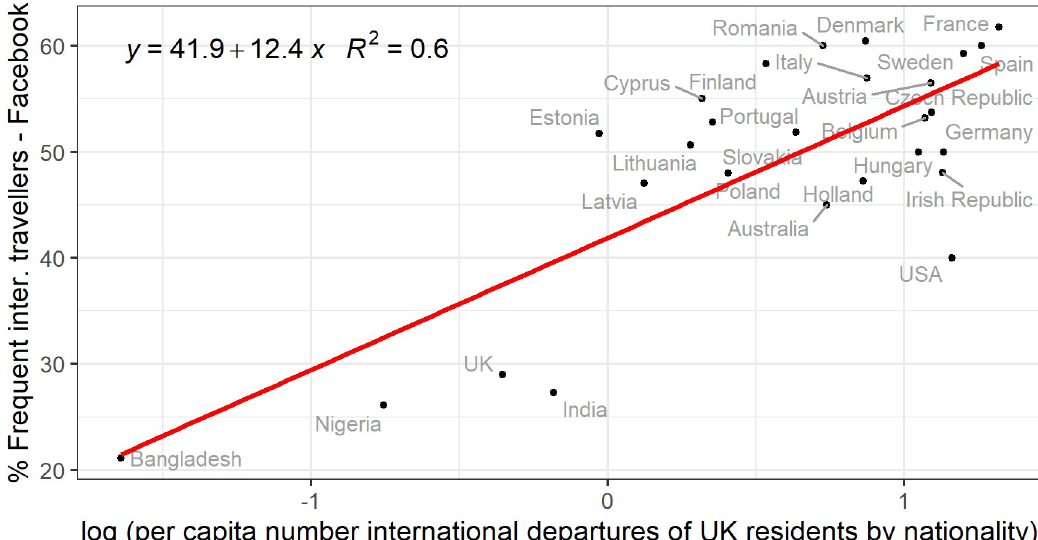
Fig 1. International travelling behaviour in the UK by nationality/previous residence. The x-axis shows the log of the per capita number of international departures of UK residents by nationality from March 2018 to August 2018 as estimated by the UK IPS survey. The y-axis shows the percentage of Facebook users who live in the UK and have made at least one international travel from March 2019 to August 2019 by country of previous residence.